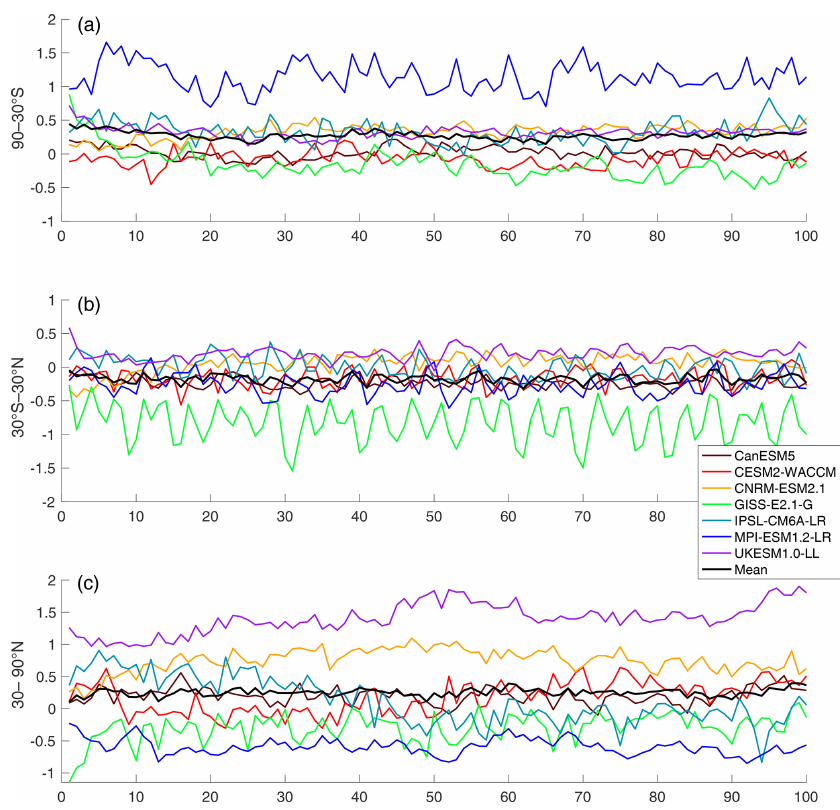
Figure 2. Annual mean surface temperature (K) in each model averaged over 90–30 ◦ S (a) , 30 ◦ S–30 ◦ N (b) , and 30–90 ◦ N (c) . The ensemble mean is plotted as thick black